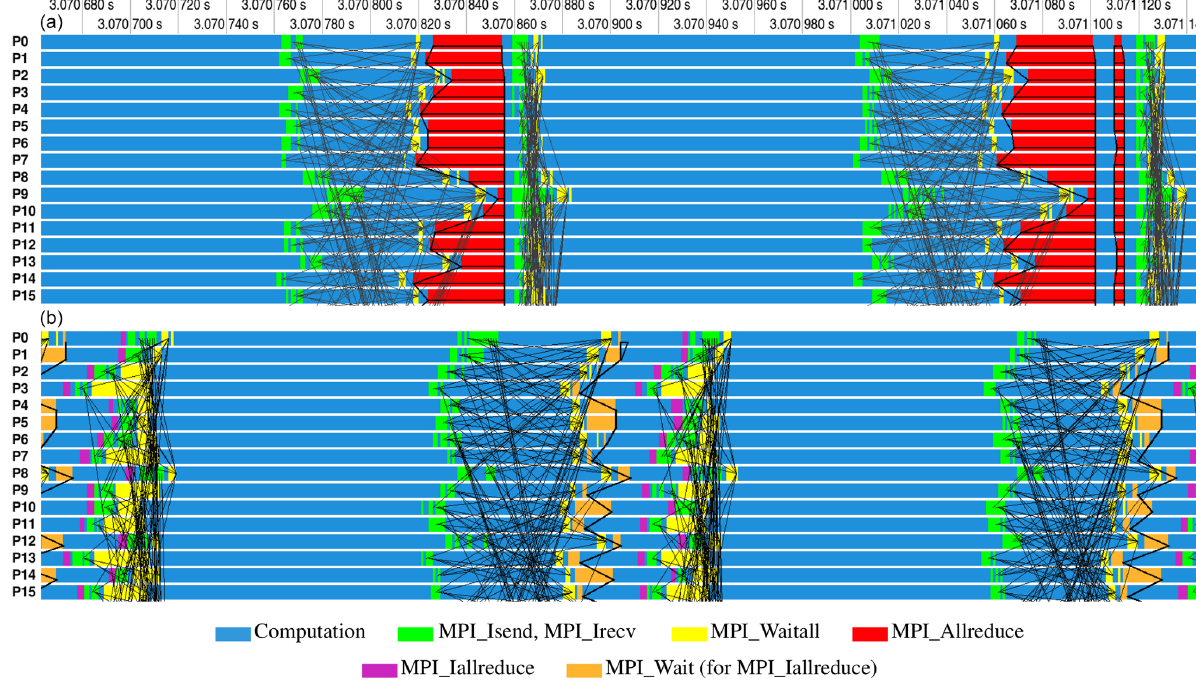
Figure 9. Above: one iteration of the classical BiCGStab scheme (Algorithm 2) in the Intel Trace Analyzer and Collector. Observe the blocking due to computing global sums in scalar products via MPI_Allreduce. In addition, communication is needed for halo exchanges that often overlap with independent computations. Below: one iteration of the pipelined BiCGStab scheme (Algorithm 3). The global sums are now initiated by a nonblocking call to MPI_Iallreduce and finished by MPI_Wait. In between, major computations such as a matrix–vector product and a preconditioning step are performed also including halo